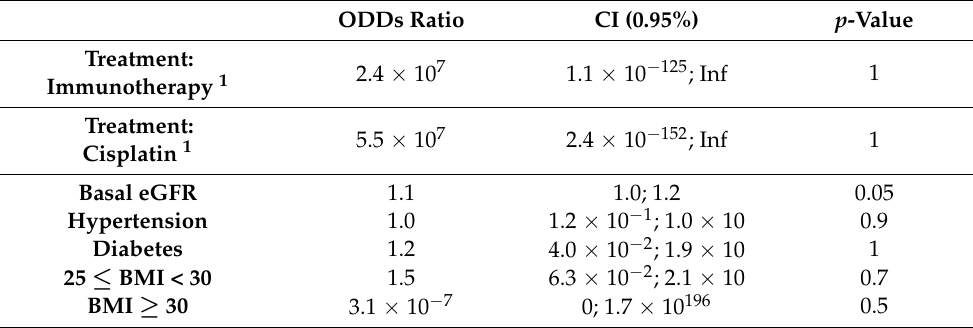
Table 4. Multivariable logistic regression. 1 : reference level treatment: